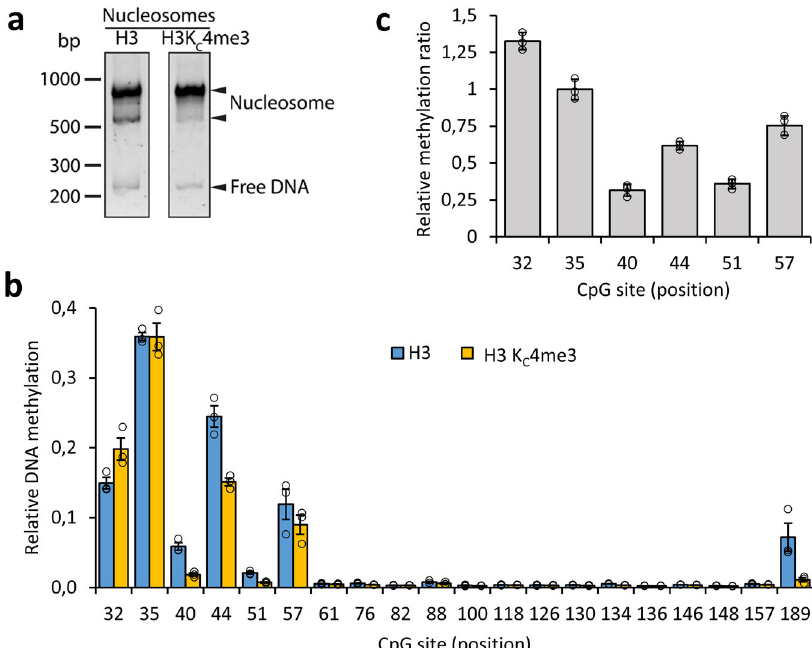
Fig. 3 Effect of H3K C 4me3 on the methylation of nucleosomal DNA by DNMT3A2. a Gel shift assay of reconstituted unmodi fi ed and H3K C 4me3 containing nucleosomes. Successful nucleosome reconstitution is con fi rmed by the strong shifted DNA bands. b Relative methylation of each CpG site observed in three independent replicates of the competitive methylation of unmodi fi ed and H3K C 4me3 nucleosomes. Error bars represent the SEM. c Ratio between the competitive methylation levels of H3K C 4me3 and unmodi fi ed nucleosomes for the CpG sites located in the linker DNA. Note that H3K C 4me3 reduced methylation of the 40-57